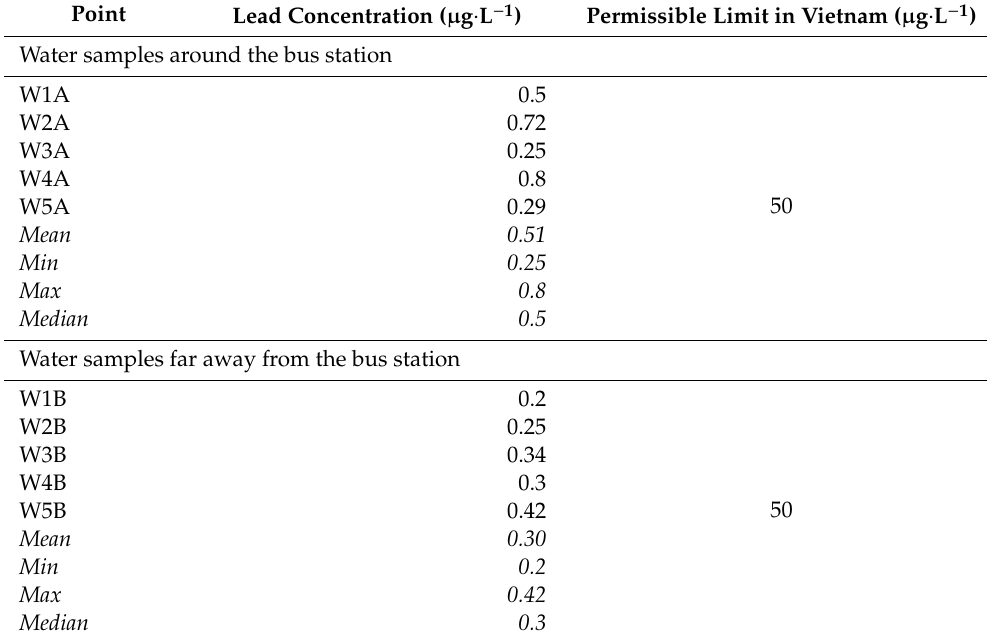
Table A2. Raw data of lead concentration measured from the water and vegetable